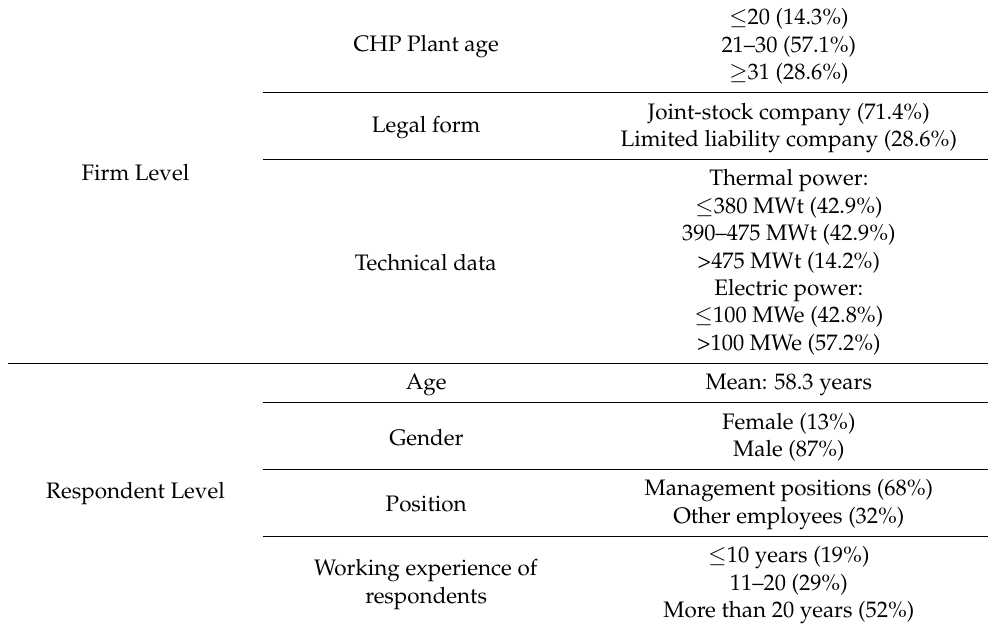
Table 2. Characteristics of the research sample. Source: own